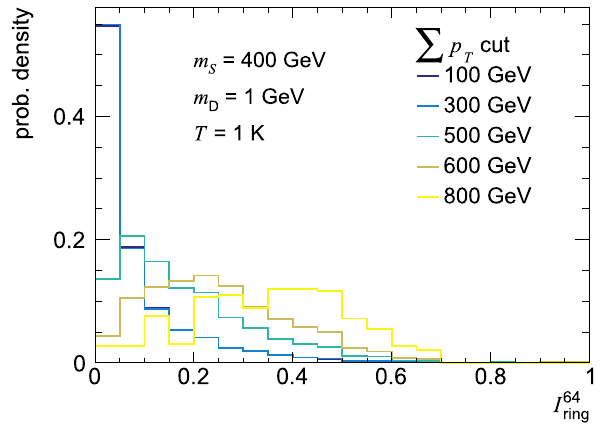
Fig. 20 Isotropy distributions are shown for different values of the (cid:17) (cid:17) p T event selection. The p T is calculatedfor generator level tracks that are defined as status = 1 charged particles with p T > 0 . 1 GeV and | η | < 2 . 4. The production mode is Gluon Fusion (GF) with a dark photonbranchingfractionof BR ( A (cid:7) γ → ee ,μμ,ππ) = ( 40 , 40 , 20 ) %